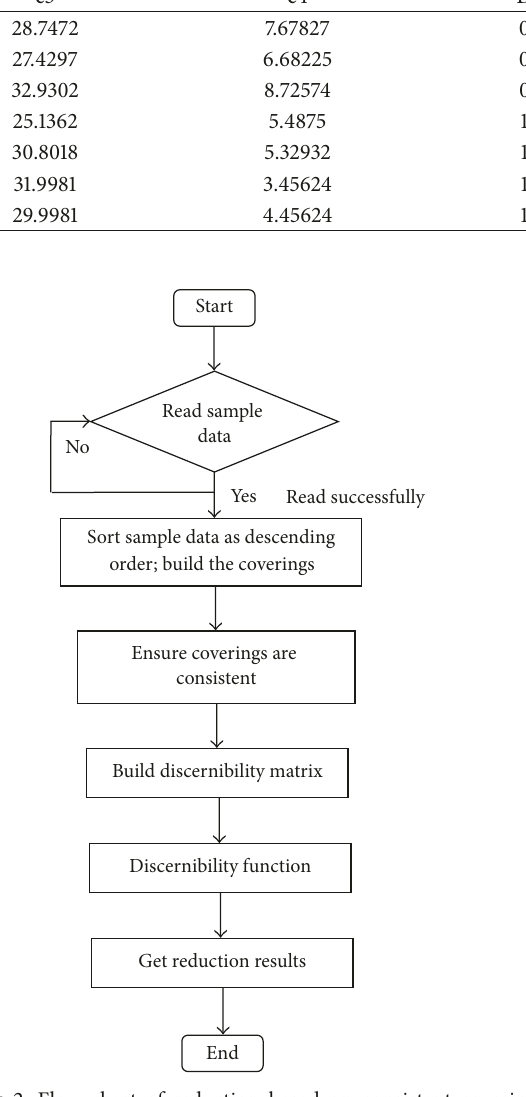
Figure 2: Flow chart of reduction based on consistent covering rough